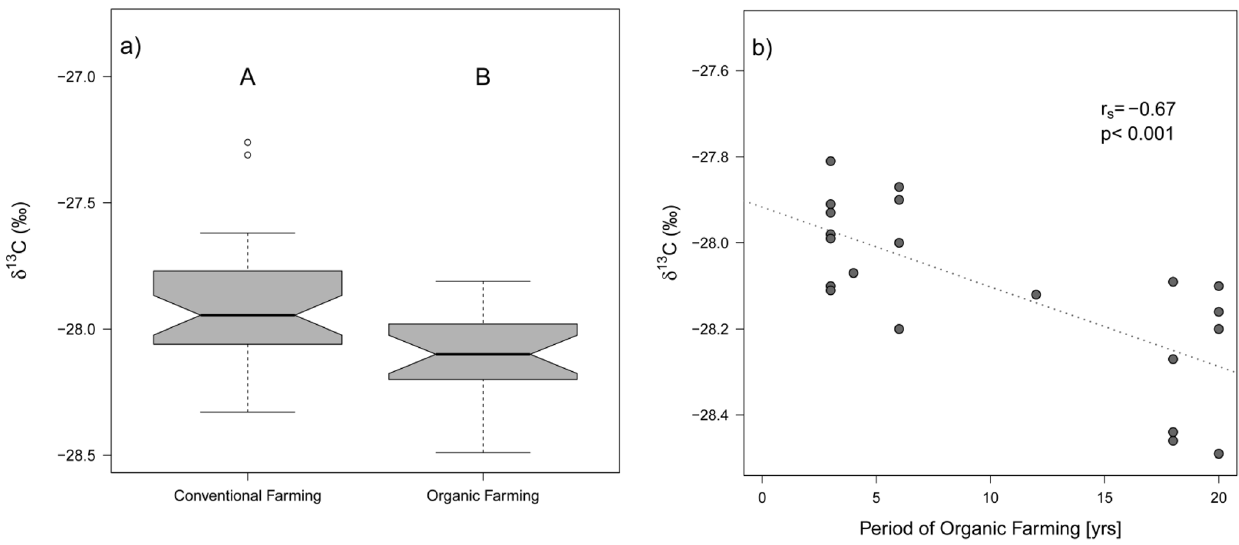
Figure 2. d 13 C abundances in soil of a) organic vs. conventional grasslands and b) organic grasslands in relation to the time since certification ( r s = 2 0.70; p , 0.001). Letters indicate significant group differences according to ANOVA analyses (for details see Table 1 & 2).